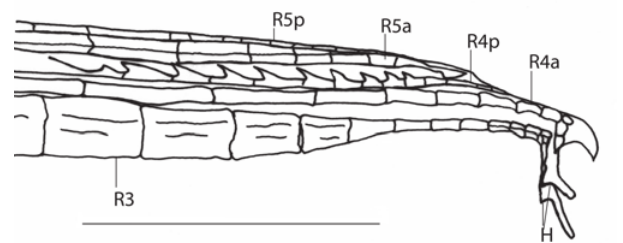
Fig. 33. Gonopodium tip of Phalloceros alessandrae , MCP 30402. R3, R4a, R4p, R5a, R5p indicate gonopodial rays. Scale bar 1